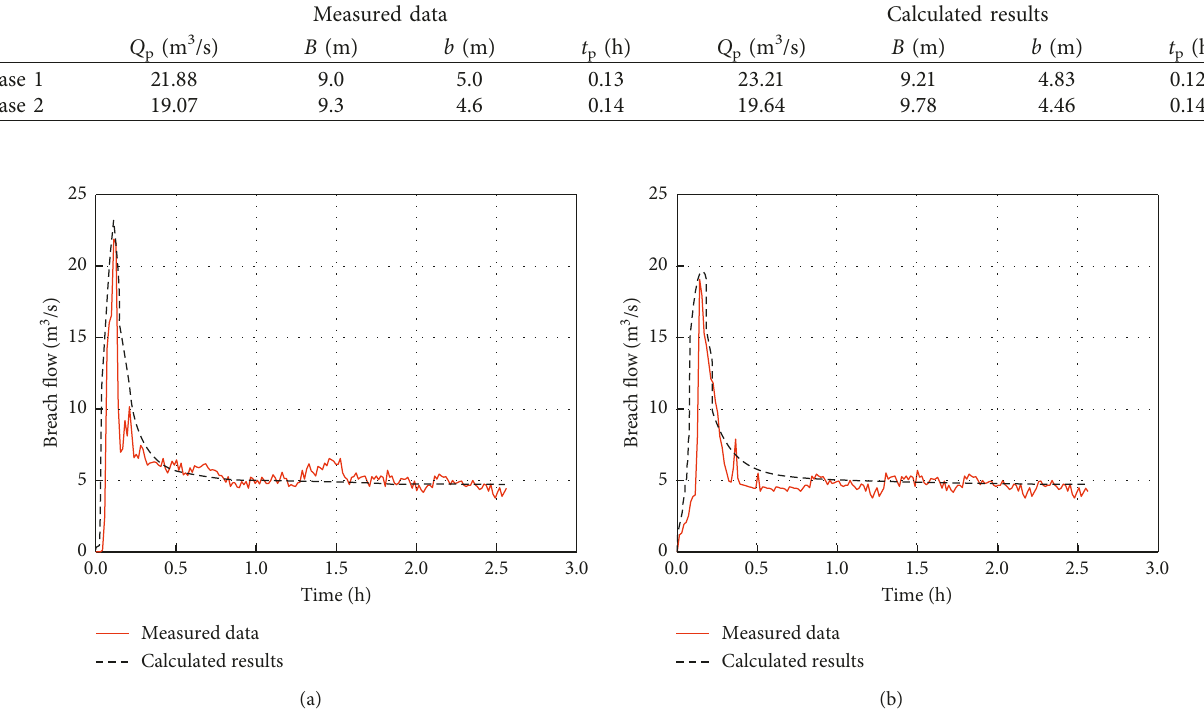
Figure 10: The comparisons of the calculated and measured breach flow hydrographs. (a) Case 1 (b) case 2.